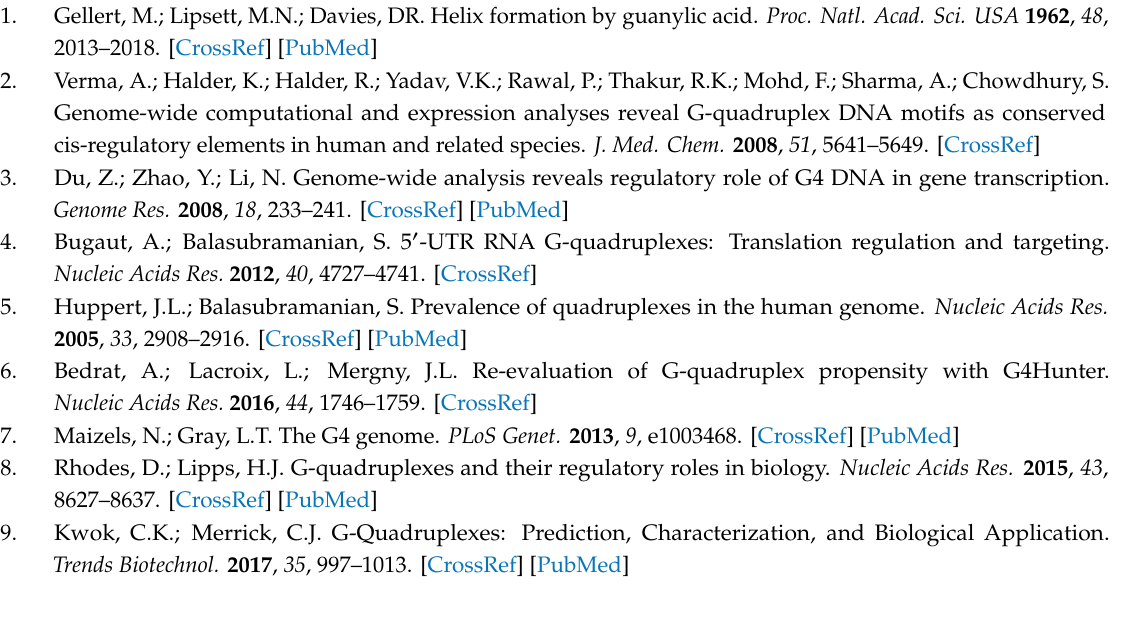
Figure S1: Quadruplex motifs found by viral genome classification and by strand, Figure S2: Quadruplex motifs found in eukaryotes, by strand, Figure S3: Genome metrics and PQS content in the Herpesviridae family of dsDNA viruses, Figure S4: G4 motif loop content in various eukaryotes, Figure S5: Consensus motif discovery in the quadruplex sequences found in promoter regions of the human genome, Table S1: G-quadruplex sequences (and coordinates) found in seven viral taxa, Table S2: Genome metrics and quadruplex sequences for 93 herpesvirus